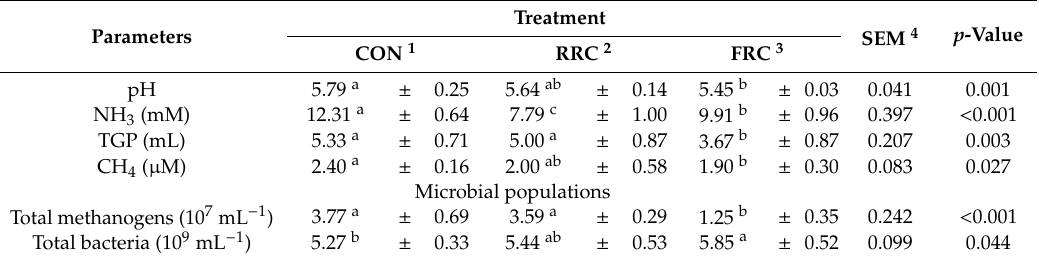
Table 6. E ff ect of diets containing raw rapeseed cake (RRC) and fermented rapeseed cake (FRC)